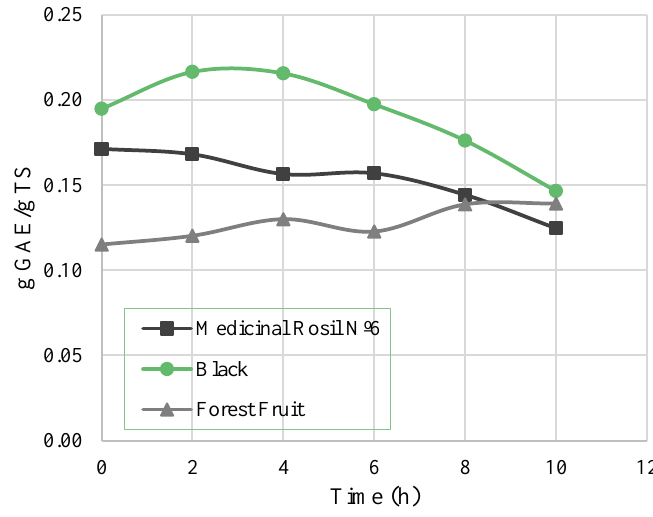
Figure 6. Total phenolic content through the concentration process.